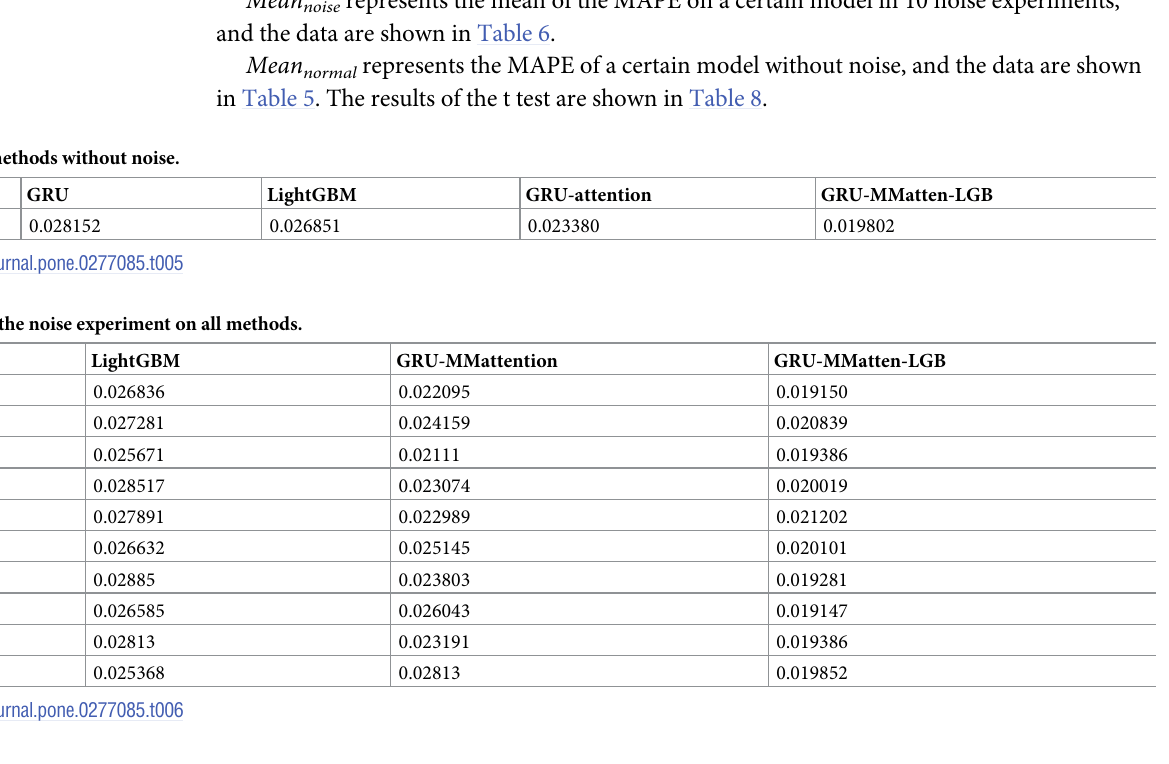
Table 7. The results of the Shapiro–Wilk test.